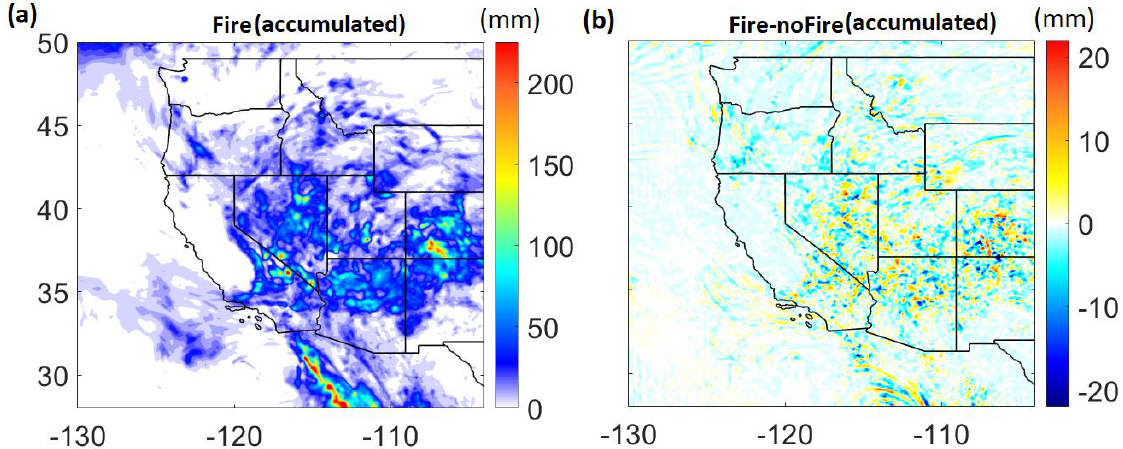
Figure 13. Spatial distribution of accumulated ( a ) precipitation in mm from the ‘Fire’ simulation, and ( b ) difference in precipitation in mm between the ‘Fire’ and ‘noFire’ simulations for the first half of September 2017.